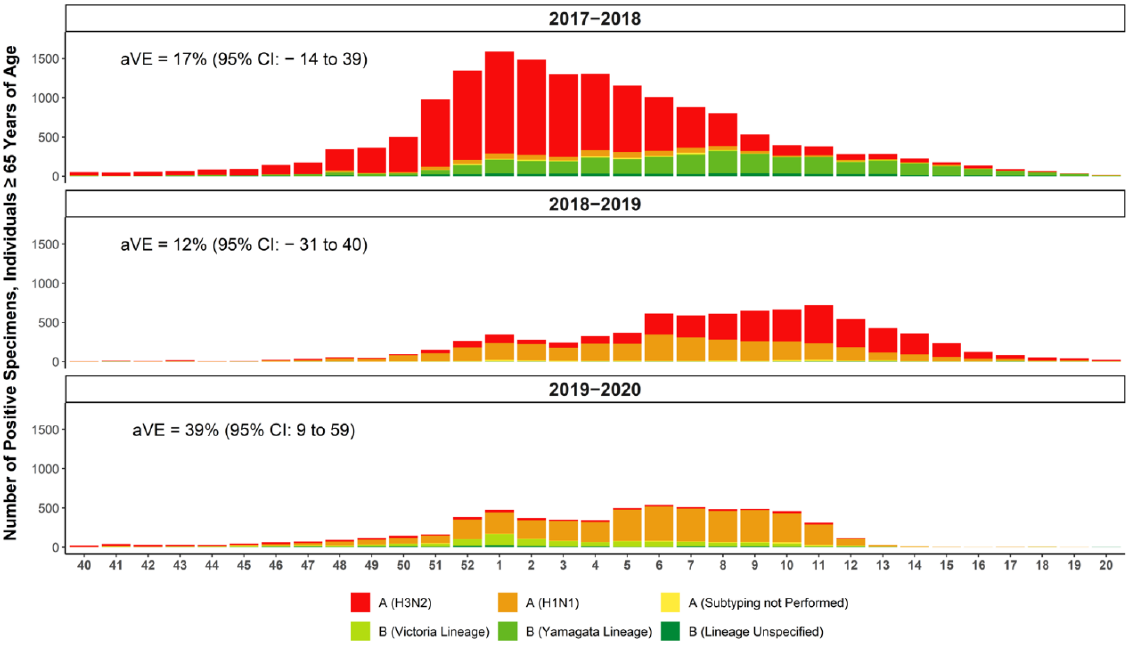
Figure 2. Summary of influenza-positive specimens, specified by strain, from individuals ≥ 65 years of age, as reported by public health laboratories across the United States to the CDC and absolute vaccine effectiveness (aVE) against any strain as estimated by the CDC for individuals ≥ 65 years of age [26,27,37,40–42] .